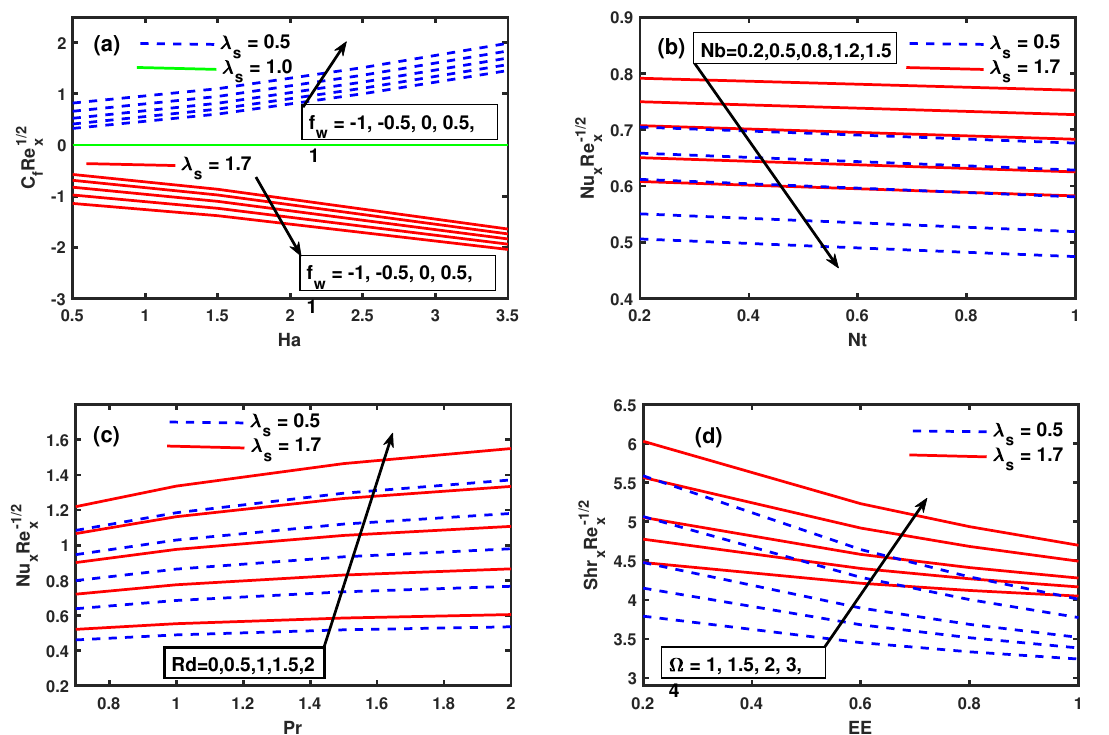
Figure 6. Fluctuation of C f Re 1/2 x (Skin friction coefficient) along with Hartmann number ( Ha ) and suction/injection ( f w ) ( a ), Nusselt number ( Nu x Re − 1/2 x ) with thermophoresis (Nt), Brownian motion ( Nb ) ( b ), Prandtl number ( Pr ) , and radiation ( Rd ) ( c ), and Sherwood number ( Shr x Re − 1/2 x ) along with activation energy ( EE ) and chemical reaction rate ( Ω ) ( d